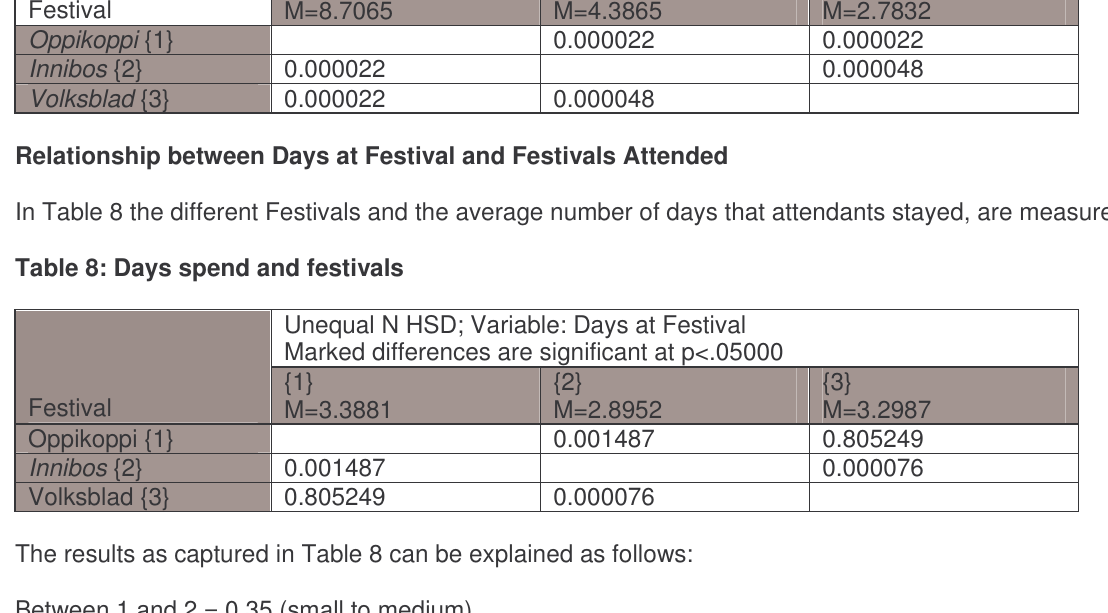
Table 7: Travelling group (Tukey HSD) Unequal N HSD; Variable: Travelling group Marked differences are significant at p < .05000